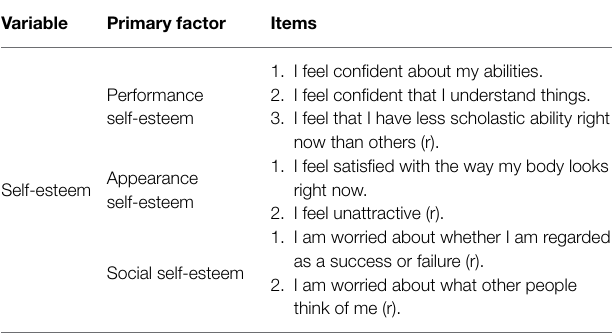
TABLE 7 | Self-esteem variable measurement